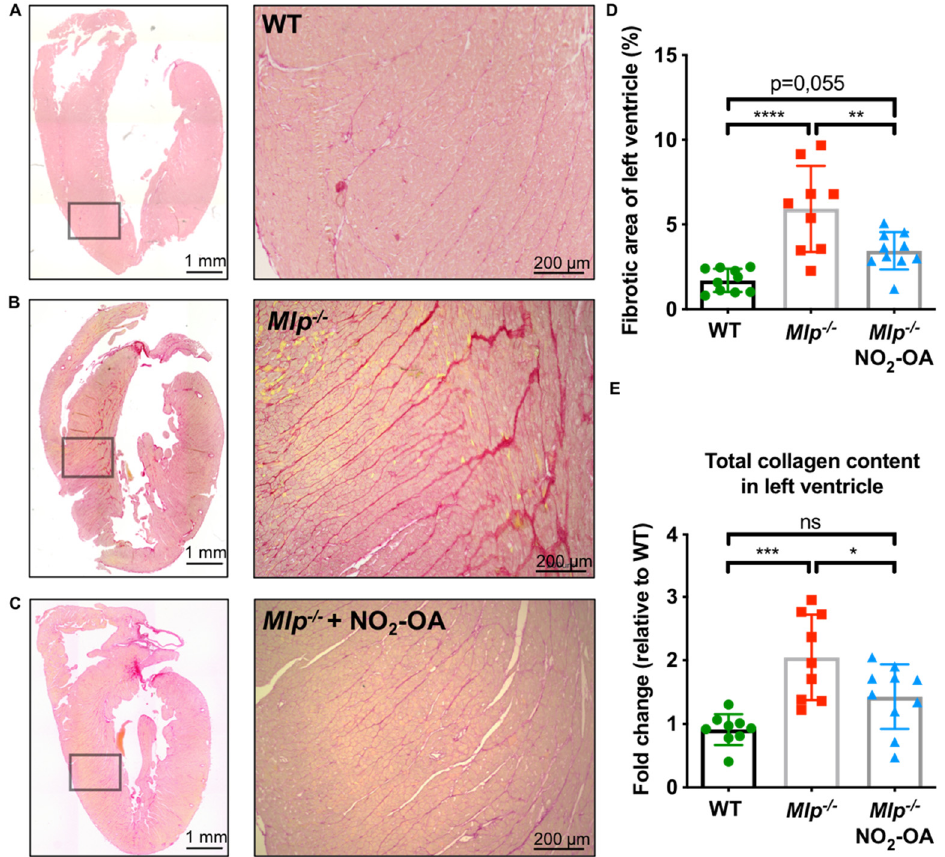
Figure 2. Effect of NO 2 -OA on interstitial myocardial fibrosis in DCM. ( A – C ) Representative images of whole heart sections and magnified areas from WT, Mlp − / − , and Mlp − / − + NO 2 -OA stained with picrosirius red for collagen detection. ( D ) Analysis of fibrotic area shows significantly reduced interstitial fibrosis in mice treated with NO 2 -OA. ( E ) Biochemical analysis of total collagen content in LV tissue homogenates reveals a reduction of collagen by NO 2 -OA. Data are expressed as mean ± SD, * p < 0.05, ** p < 0.01, *** p < 0.001, **** p < 0.0001, one-way ANOVA with Tukey multiple comparison test, n = 9–10 as indicated, scalebar as indicated.